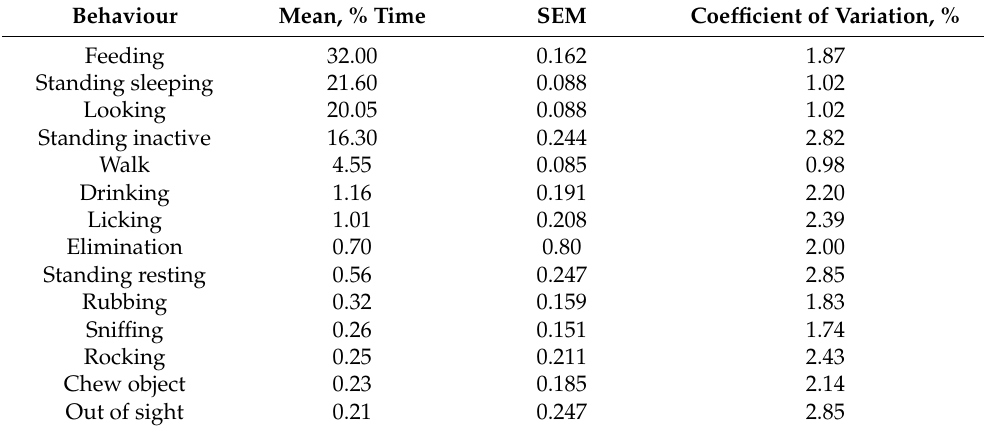
Table 2. Mean values for behaviours: percent of time spent by each horse, in descending order, together with the SEM and CV of each